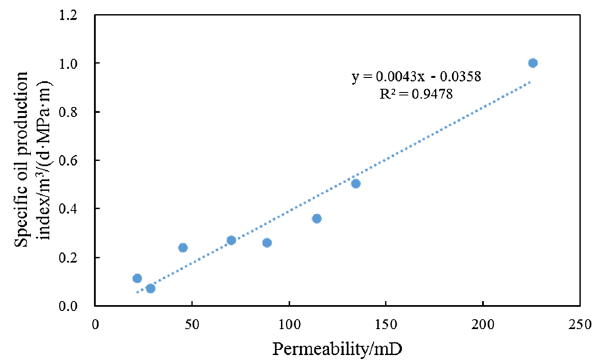
Fig. 12 Relationship between corrected permeability and specific production index